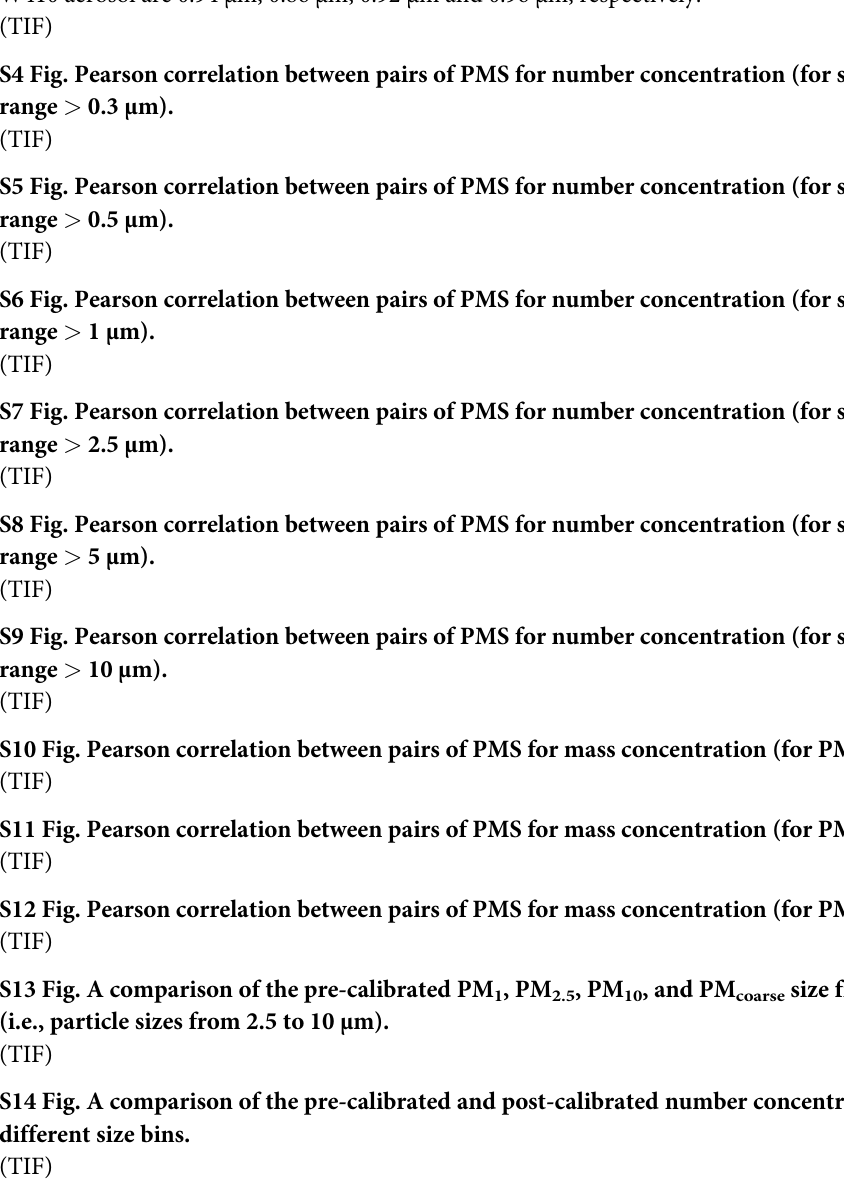
). 1 ). 2.5 ). 10 , PM , PM , and PM size fraction 1 2.5 10 coarse